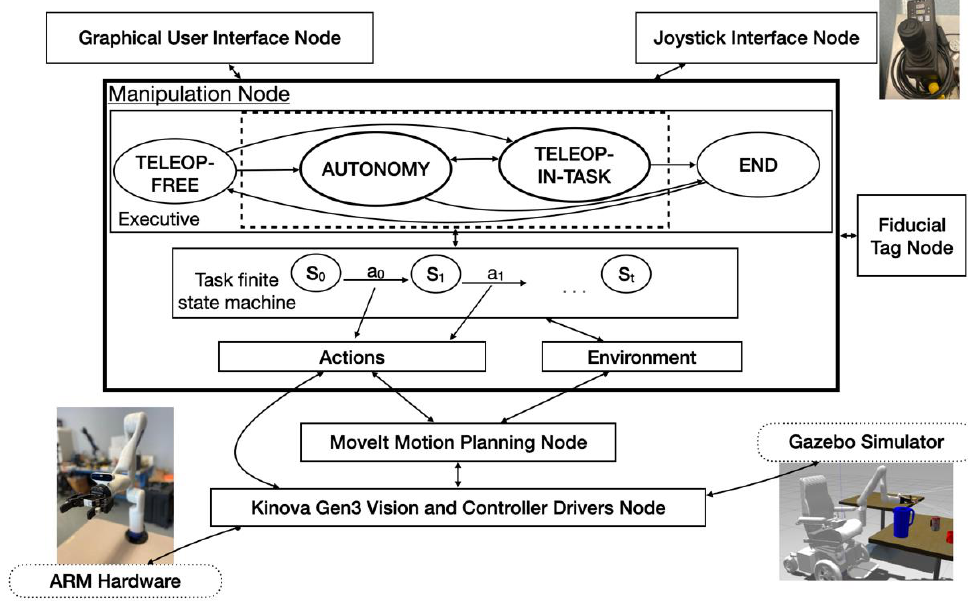
Figure 2. VGS software system